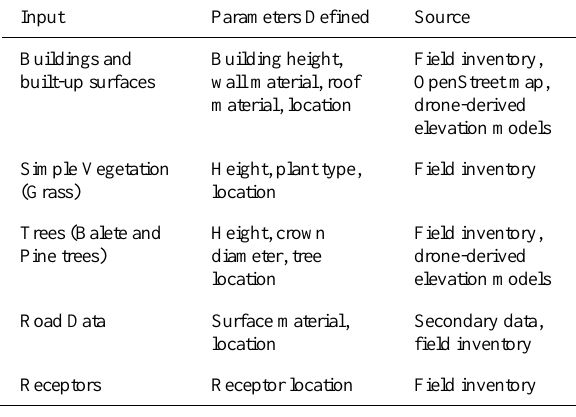
Table 1. ENVI-met inputs, information defined and data source. Each inputs were modeled in ENVI-met Monde while 3D vegetation from Albero were added in ENVI-met Spaces.